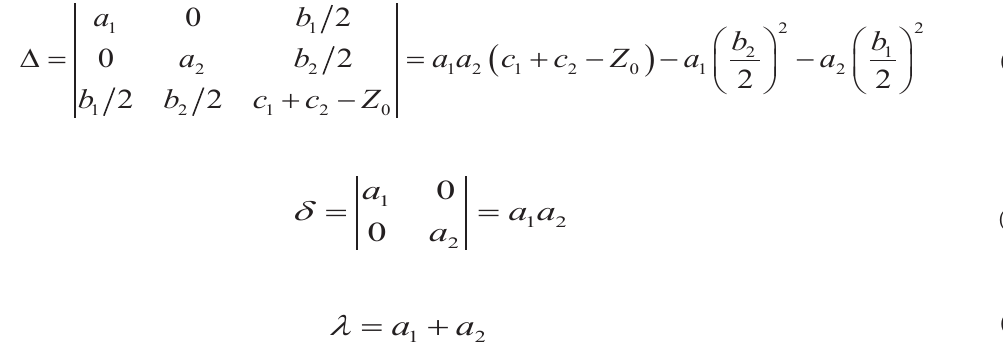
Figure 3. Curve types obtained according to the invariant’s values.